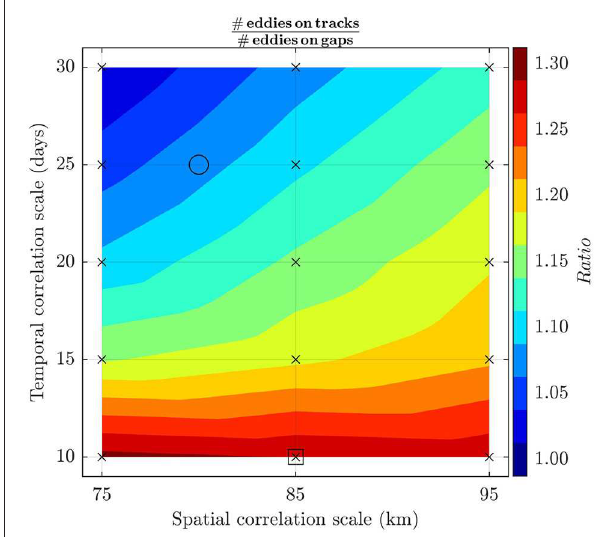
FIGURE 4 | Ratio of number of eddies along Topex/Poseidon tracks and number of eddies between tracks depending on the spatial (R) and temporal (T) correlation scales used by the optimal interpolation algorithm. The contour plot has been computed linearly interpolating the points indicated by black crosses. The black square (circle) indicates the combination of parameters that ( Amores et al., 2018) used for the Mediterranean Sea (North Atlantic Ocean) and that gave the closer results to the Copernicus SLA